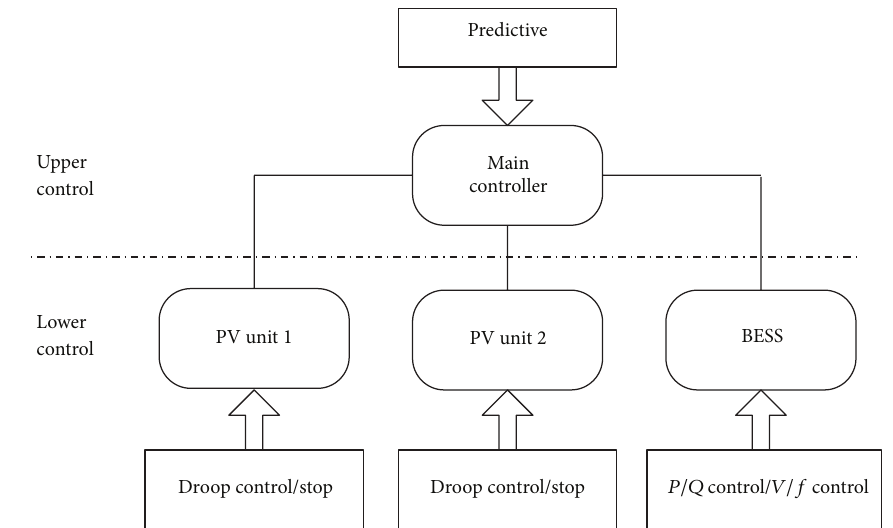
Figure 4: MG system control strategy under the islanded mode.